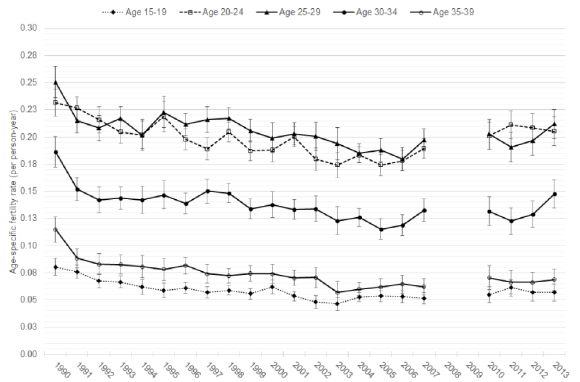
Fig 4. Annual ASFRs for women under age 40, 1990–2013.